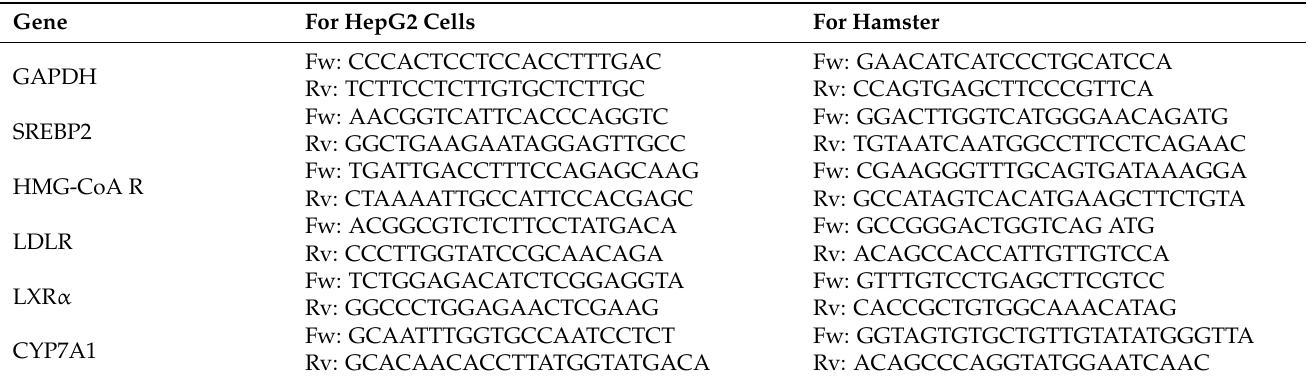
Table 1. Real-time PCR primer